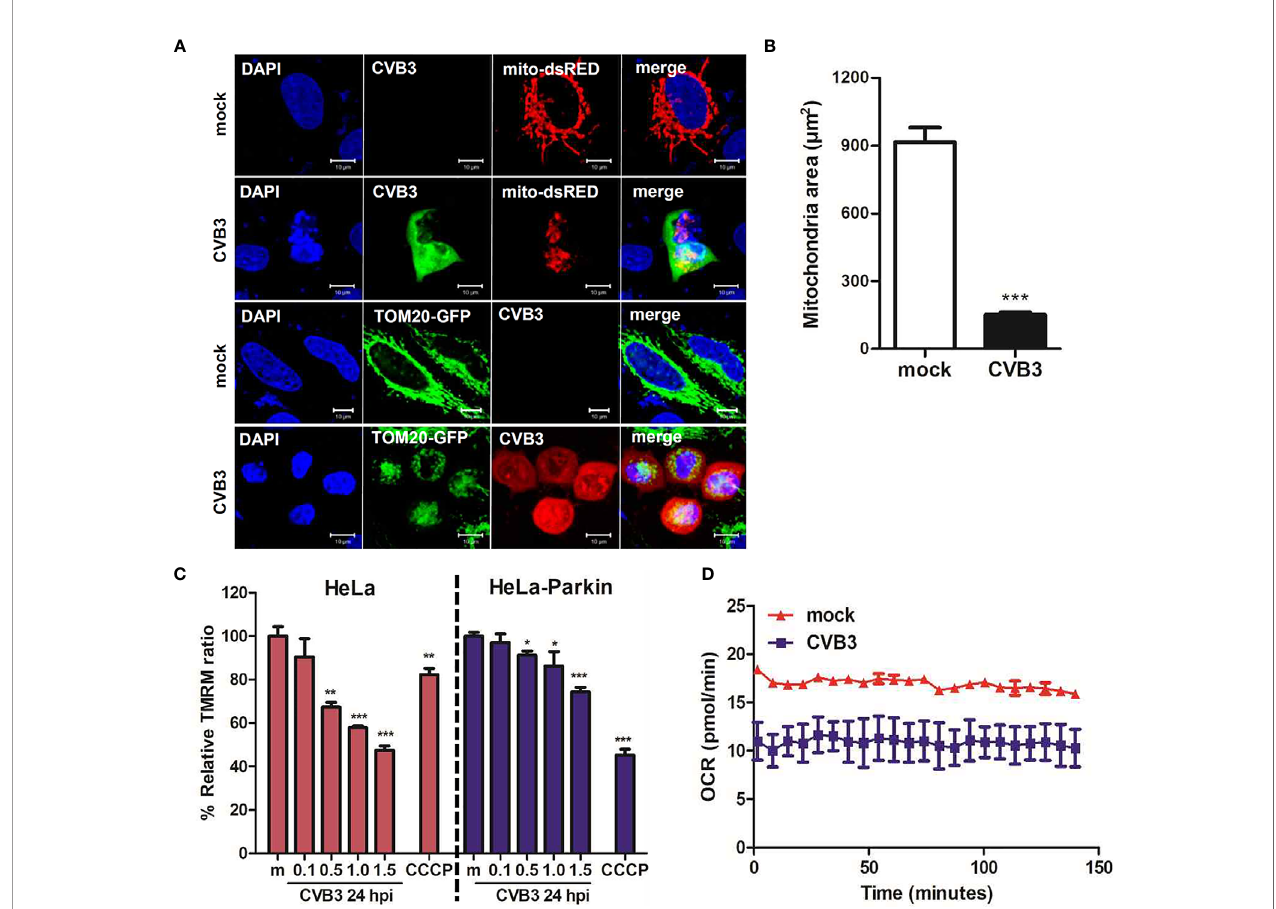
FIGURE 3 | CVB3 infection induces mitochondrial fi ssion and reduces mitochondrial membranes potential. (A) HeLa cells were transfected with mitochondrial protein-expressing plasmids (TOM20-GFP or mito-dsRED) and infected with CVB3 for 8 h. CVB3 was immunostained with anti-Coxsackievirus B3 antibody. CVB3- infected cells show fragmented mitochondria. Scale bar = 10 m m. (B) Quanti fi cation of mitochondrial area as shown in (A) is represented (n = 50). (C) HeLa or HeLa- Parkin-expressing cells were treated with CCCP for 2 h or infected with mock (m) or CVB3 at different MOIs for 24 h. Carbonyl cyanide m-chlorophenyl hydrazone (CCCP) is a known mitochondrial uncoupler, which reduces mitochondrial membrane potential (MMP). Relative tetramethylrhodamine methyl ester (TMRM) intensity in each group of live cells was measured using a VarioSkan LUX multiplate reader (mean ± SD; n = 3). *p < 0.05; **p < 0.01; ***p < 0.001, vs . mock-infected cells. (D) Oxygen consumption rate (OCR) in mock or CVB3-infected hNPCs (MOI of 5) was measured in real-time under basal conditions with an XFp Seahorse analyzer. Data represent mean ± SD of three biological